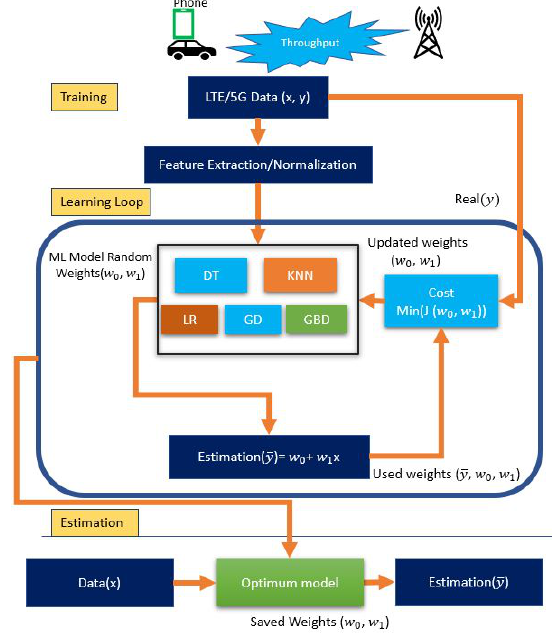
Figure 4. Training and feedback mechanism of the prediction